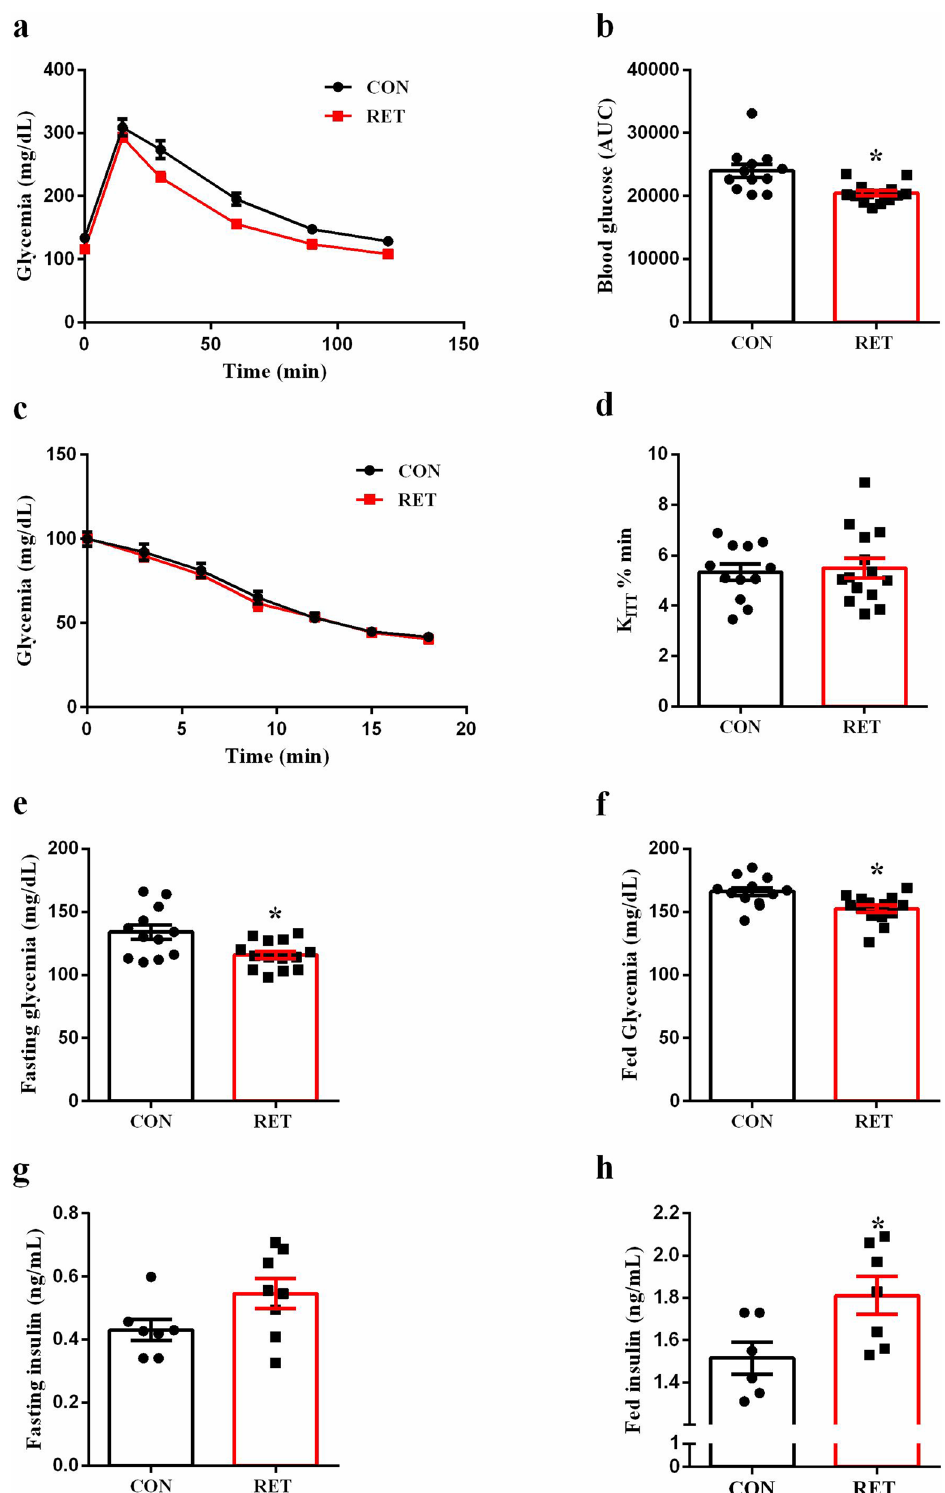
Figure 2. Resistance training improves glucose tolerance, reduces glycemia and increases fed insulinemia. Blood glucose of CON (black bar, n = 12) and RET (red bar, n = 14) during ipGTT ( a ). Area under the curve (AUC) of total blood glucose concentration of CON (black bar, n = 12) and RET (red bar, n = 14) during ipGTT ( b ). Blood glucose of CON (black bar, n = 12) and RET (red bar, n = 14) during ipITT ( c ). Constant of glucose disappearance expressed by K ITT , CON (black bar, n = 12) and RET (red bar, n = 14) ( d ). Fasting ( e ) and fed glycemia ( f ) of CON (black bar, n = 12) and RET (red bar, n = 14). Plasma insulin of CON (black bar, n = 6–7) and RET (red bar, n = 7–8) in fasting ( g ) and fed ( h ) states. Data are the mean ± SEM. *P ≤ 0.05 (Student’s